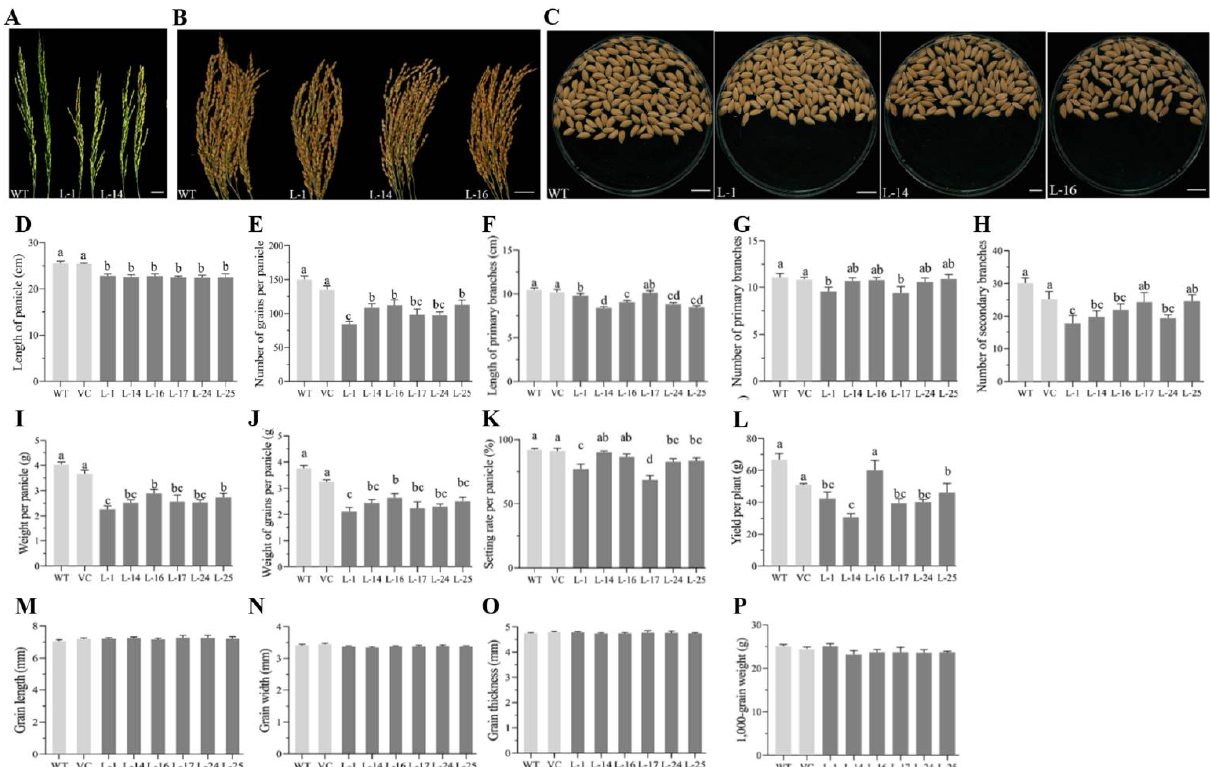
Figure 8. Ectopic expression of TaSPL3 significantly affected panicle and yield traits in transgenic rice lines. Comparison of panicle morphology at immature ( A ) and mature stages ( B ), as well as grains per panicle ( C ) between TaSPL3-OE transgenic lines and wild-type plants, showed that ectopic expression of TaSPL3 led to shorter panicles with fewer secondary branches. ( D – P ) Detailed analyses of panicle traits and grain traits demonstrated that ectopic expression of TaSPL3 affected some panicle traits, but not grain traits ( M – O ) and thousand kernel weight ( P ). The analyzed panicle traits included length of primary branches ( F ), number of primary branches ( G ), number of secondary branches ( H ), weight per panicle ( I ), weight of grains per panicle ( J ), number of vacant grains per panicle ( K ), and yield per plant ( L ). The bar plots show mean values and standard error of the mean (S.E.M.), with mean values marked by different letters differing significantly ( p < 0.05) among the lines.